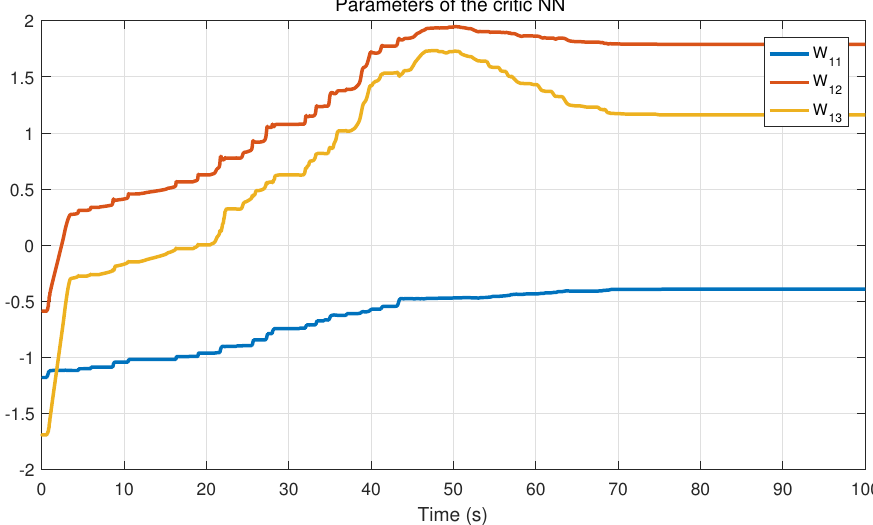
Figure 3. Evolution of the critic estimates for player